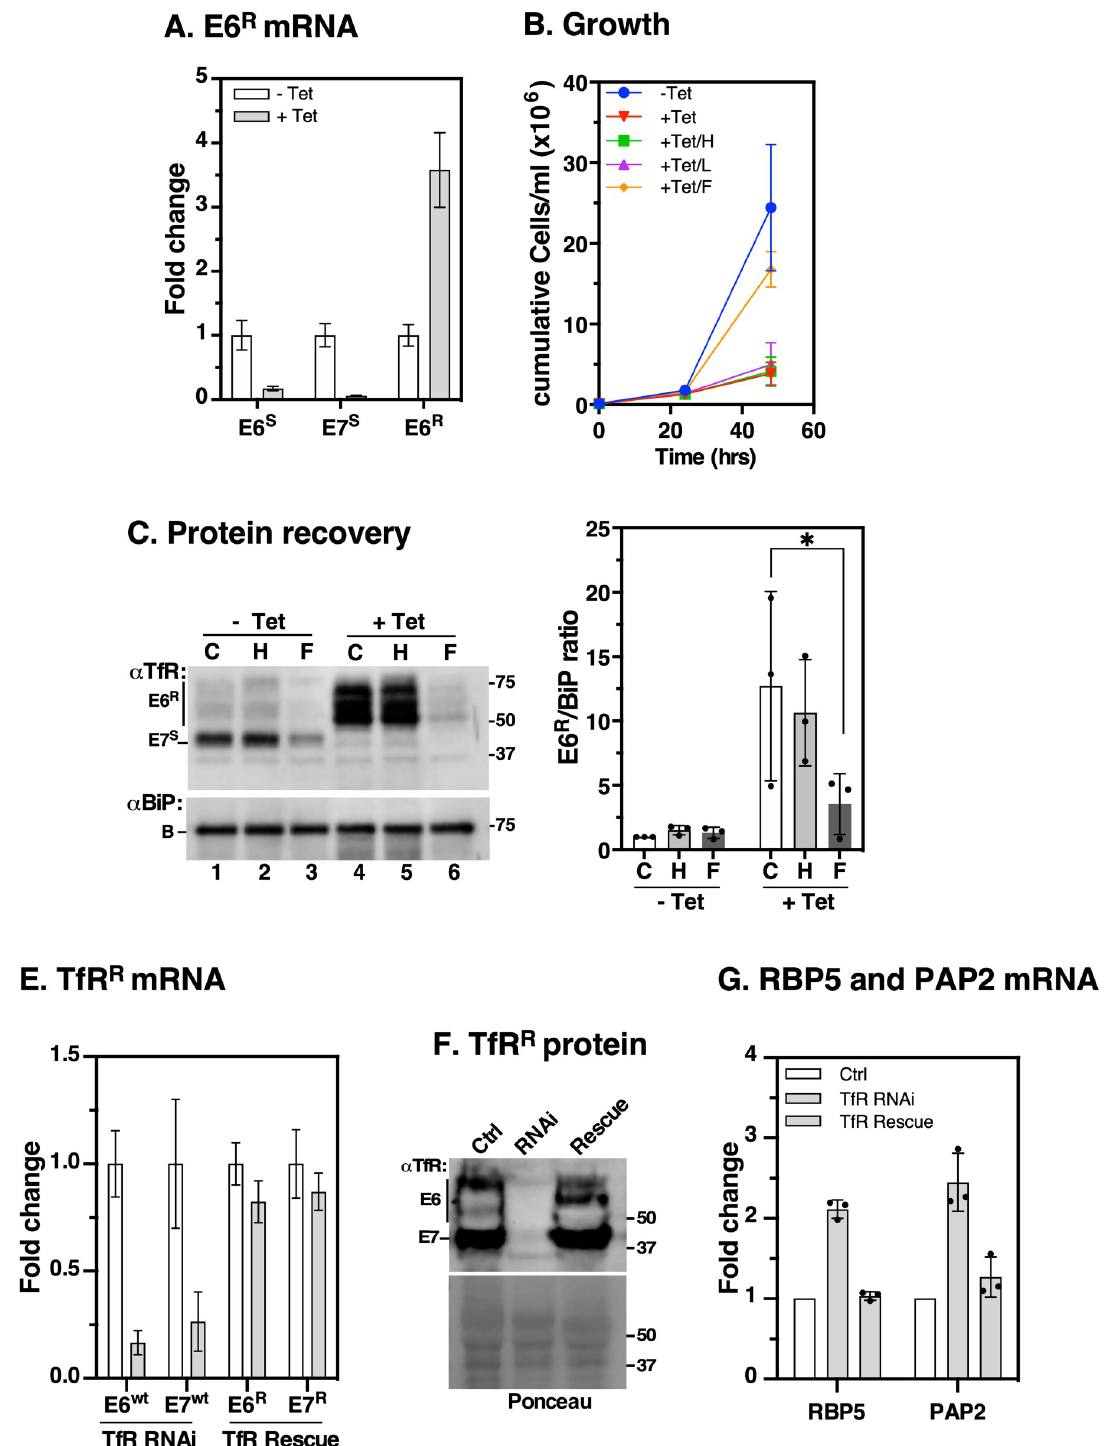
Fig 4. Effect of exogenous iron on growth and E6 R expression in TfR-depleted cells. A . Generation of RNAi-resistant E6 R reporter cell line to monitor the iron starvation response following TfR silencing. Parental TfR RNAi cells were transfected with an RNAi-resistant E6 ( E6 R ) construct replacing native E6 CDS but retaining its native 5’- and 3’- UTRs. RNAi was induced with tetracycline (+Tet, 24 hr), and mRNA levels of RNAi-sensitive E6 S , E7 S , and RNAi-resistant E6 R were determined by qRT-PCR. E6 S transcripts derive from silent BESs while E7 S derive from both active and silent BESs. Fold change is calculated relative to respective un-induced controls (-Tet) with ZFP3